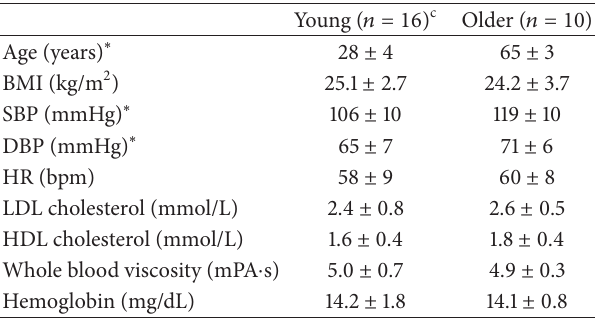
Table 1: Participant characteristics a,b .